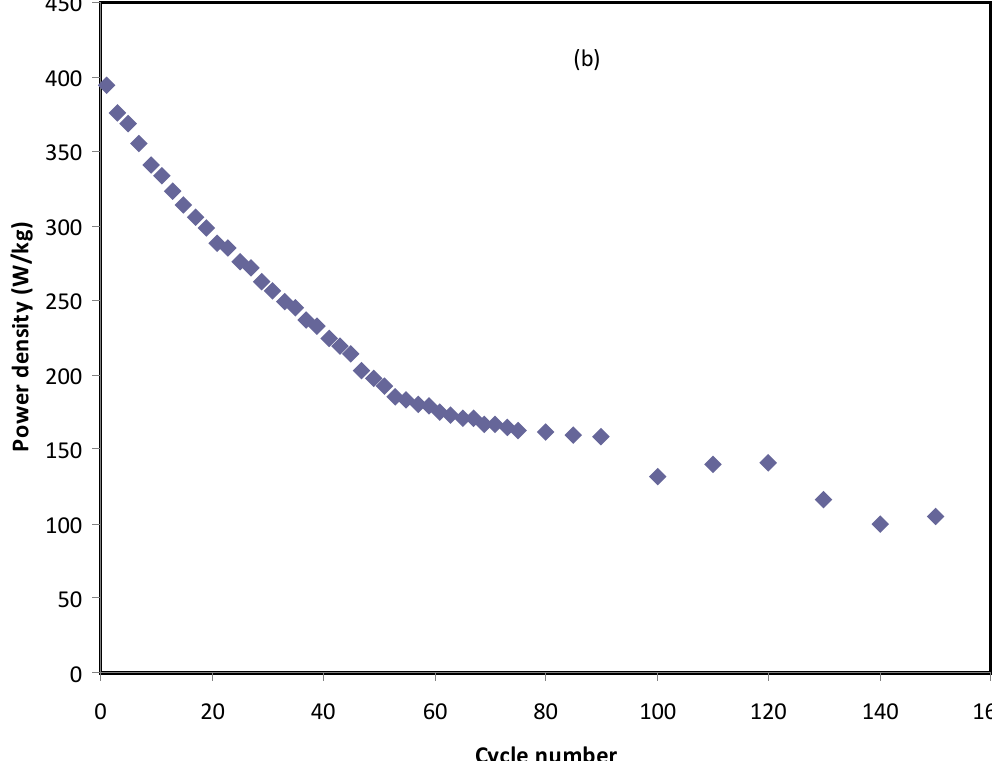
Figure 10. The EDLC parameters of ( a ) energy density ( E d ), and ( b ) power density ( P d ) at selected cycles.